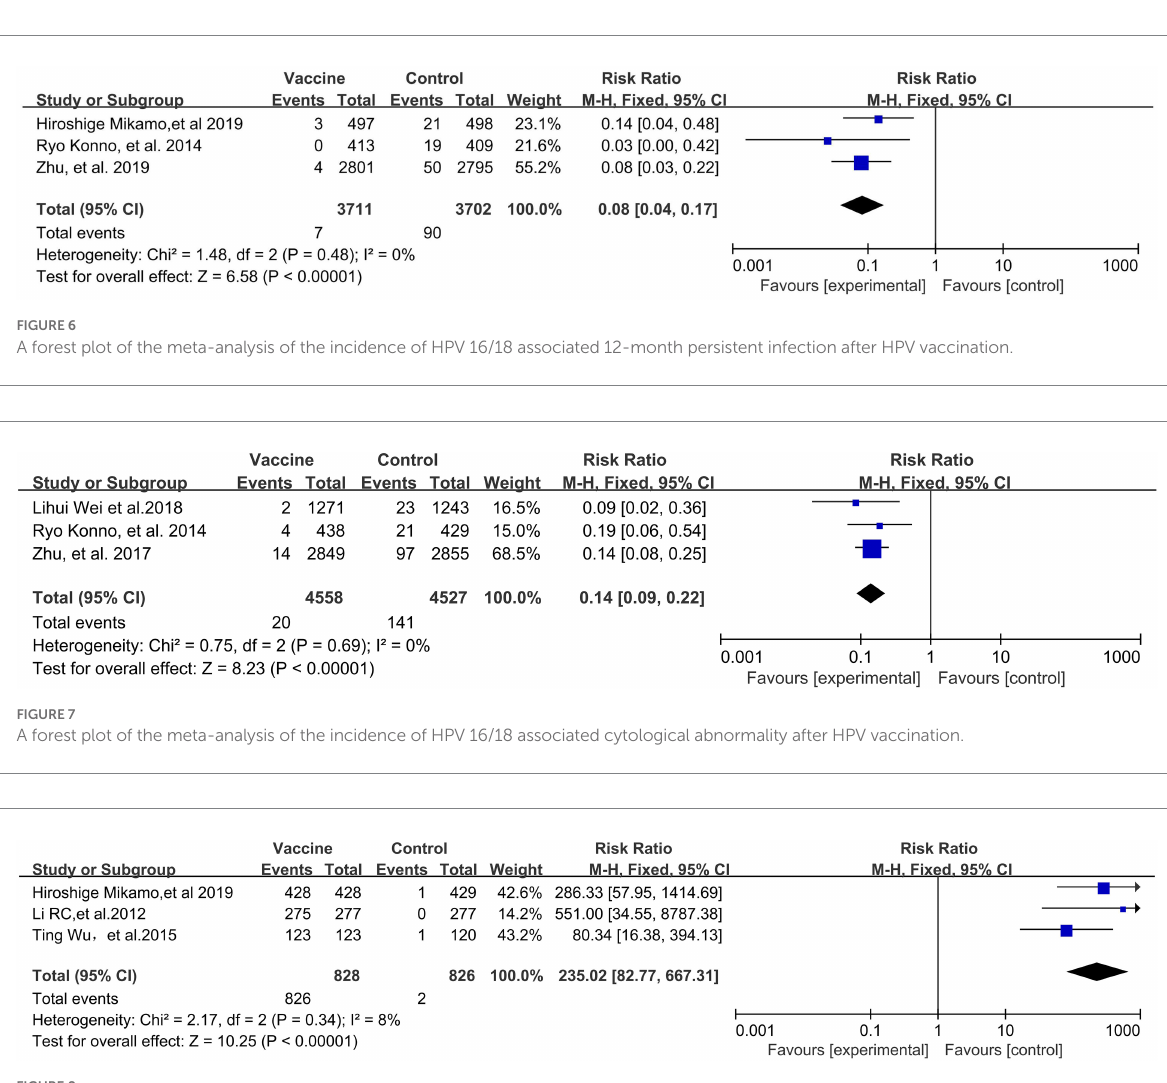
FIGURE 8 Comparison of the human palillomavirus type 16 (HPV 16) specific antibody conversion rate between the vaccinated group and the non- vaccination group in Asian